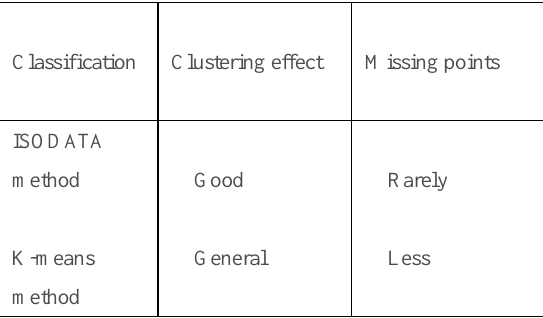
Table 3. Unsupervised classification clustering